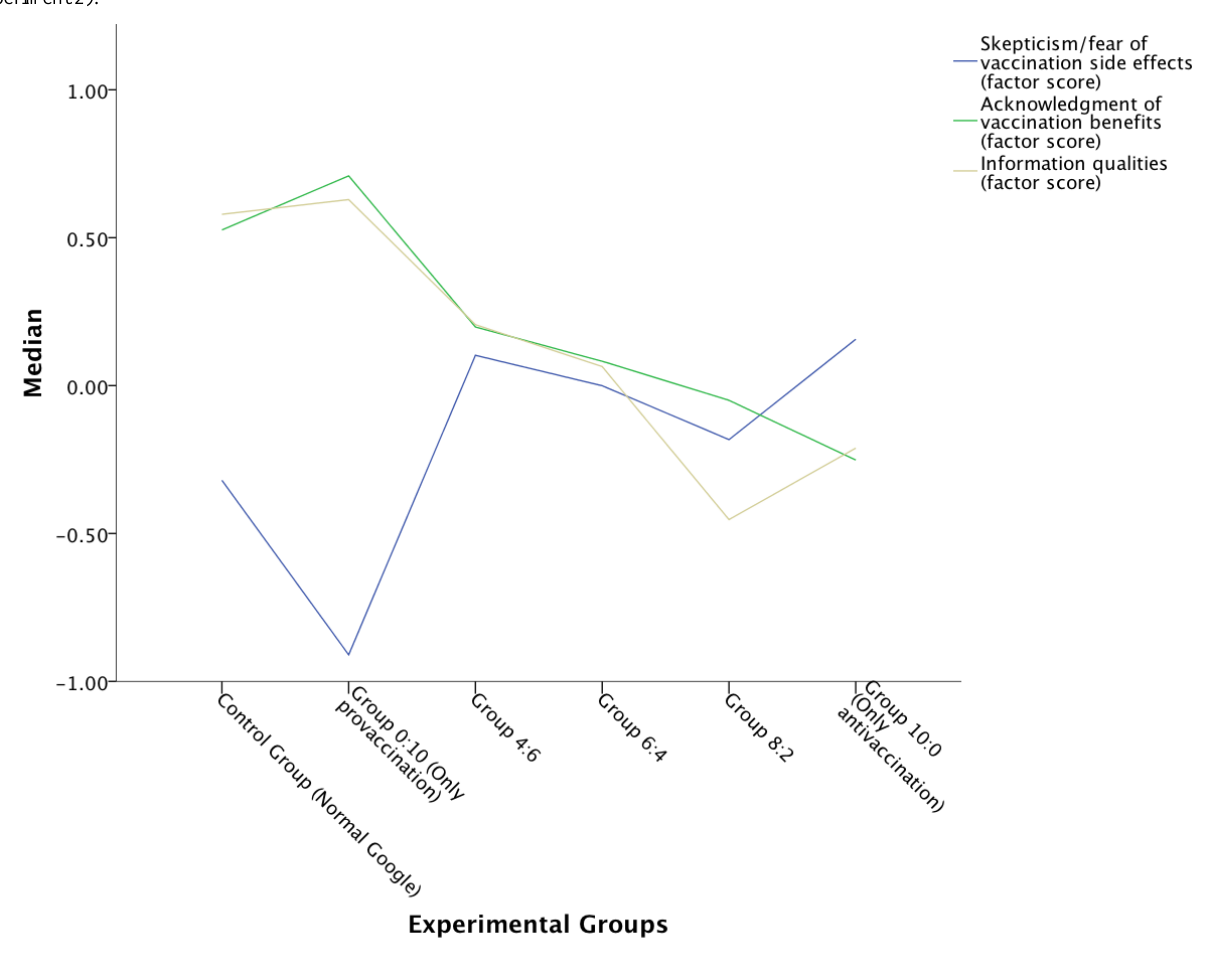
Figure 4. Median of the skepticism/fear of side effects, acknowledgment of benefits, and information quality factor scores by experimental group (experiment 2).